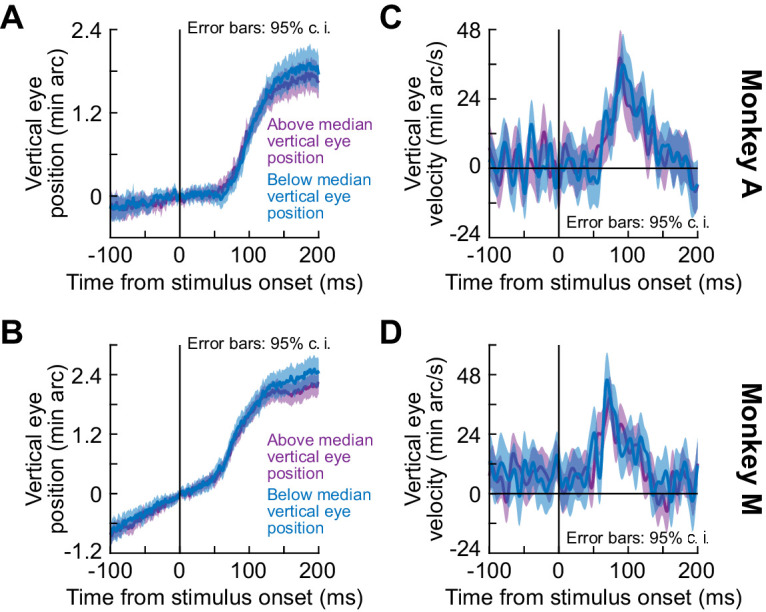
Independence of the ocular position drift response from starting eye position.For each trial of the black fixation flash paradigm (full-screen flashes), we measured average eye position in the final 50 ms before stimulus onset. Across trials within a given session, this resulted in a population of starting eye positions. We split the trials within a session based on the median value of starting vertical eye position. We then measured the ocular position drift response for all sessions when only taking the ‘above’ median group of the sessions (purple) and again when taking only the ‘below’ median group of all sessions (bluish). (A, B) Position measurements in two monkeys. We vertically aligned traces (based on starting position at stimulus onset) in order to highlight the relative change in eye position associated with the ocular position drift response (similar to how we analyzed data in all other figures; e.g. Figure 1). (C, D) Eye velocity measurements. In both eye position and eye velocity, the ocular drift response measurements were statistically very similar; there were no time intervals in which the 95% confidence intervals between the ‘above’ and ‘below’ median groups did not overlap with each other. We also confirmed that in the interval of 50–140 ms after stimulus onset, peak vertical eye velocity was not different between the two groups (p=0.63, Z = 0.48 for monkey A and p=0.46, Z = 0.74 for monkey M; Wilcoxon rank sum test). All other conventions are similar to our other analyses of the ocular position drift response (e.g. Figure 1). Similar results were obtained with the split view stimulus and white fixation flash paradigms (e.g. p=0.32, Z = −1.01, and p=0.62, Z = −0.5 for monkeys A and M, respectively, in the white fixation flash paradigm; similarly, p>0.15, Z = −1.46,–0.82, and p>0.2, Z = −0.55, 1.27, and p>0.85, Z = 0.01, 0.19 for monkeys A, M, and N, respectively, in the split view stimulus paradigm; Z-values are reported for right and left darkness for each monkey in the split view stimulus paradigm).